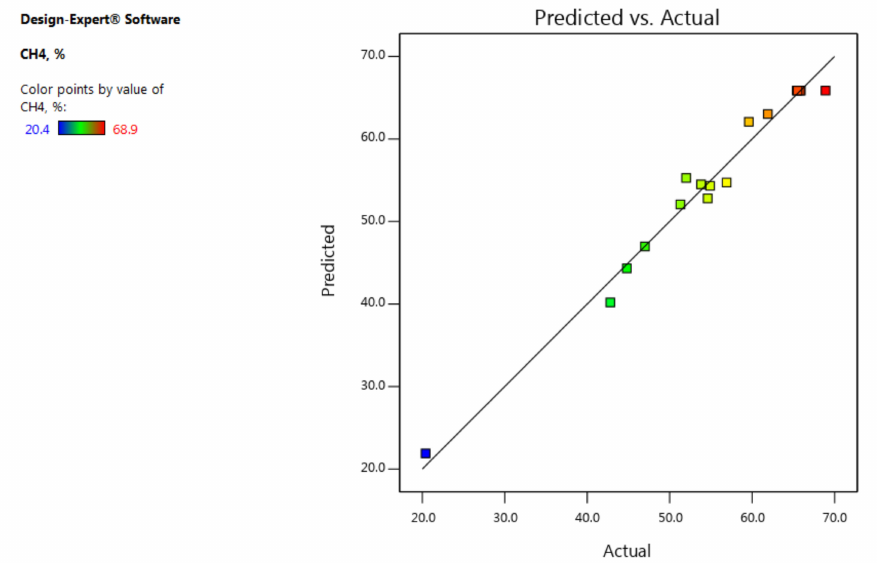
Figure 3. Scatter plot of the predicted results versus the actual ones of the CH 4 %